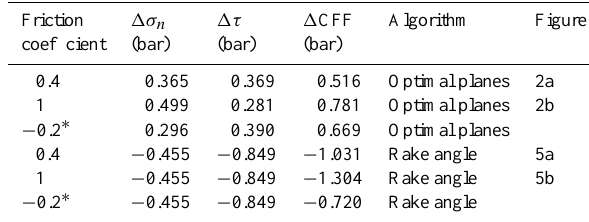
Table 6. A comparison of Coulomb stress ( 1 CFF) values at the 1986 hypocentre (45.52 ◦ N, 26.49 ◦ E) provided by different trig- gering algorithms and friction coefficients. 1 CFF is calculated on optimal failure planes at 131km depth (top three rows), and for 1986-type striking reverse faults at 131km depth, bottom three rows). Friction coefficients 0.4 and 1 assume that no pore pressure changes exist ( 1P = 0 in Eq. 2). In the case µ 0 =− 0 . 2 ,1P equals